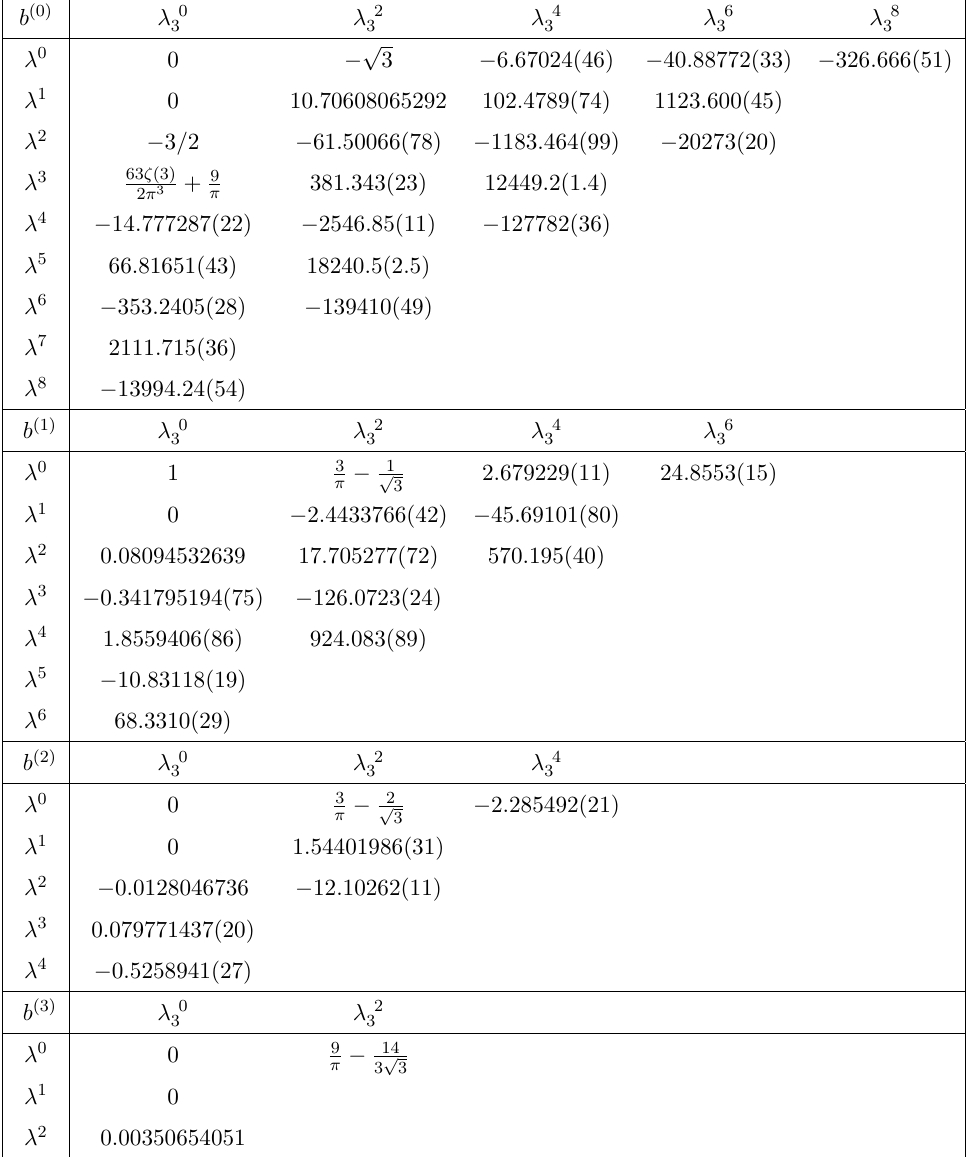
relevant for the determination of the pole mass k;l